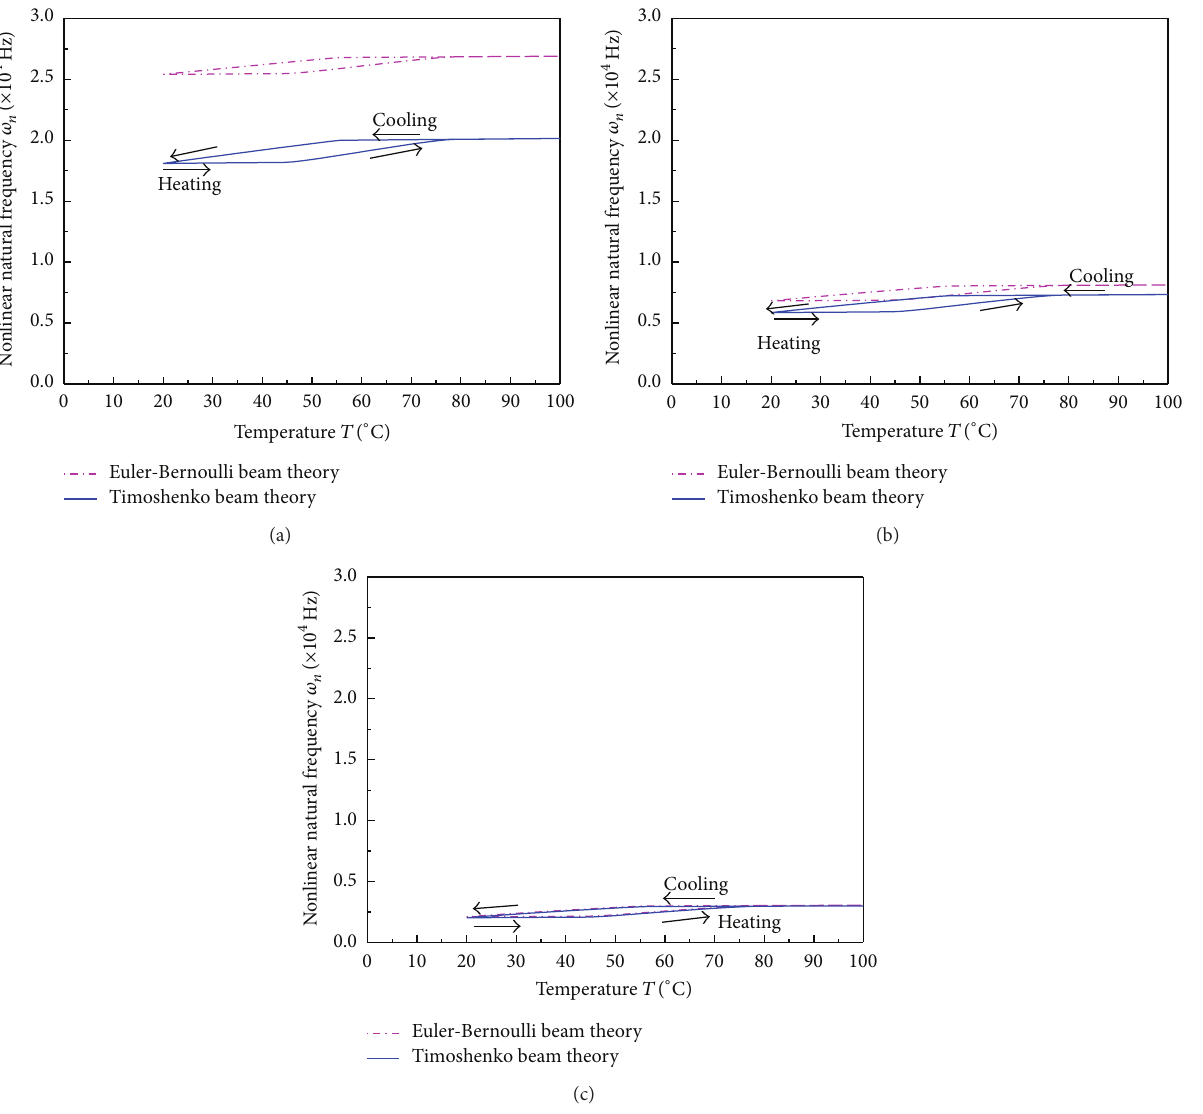
Figure 3: Variation of the nonlinear natural frequency with the actuation temperature of SMA fibers ( 𝜀 0 = 0.03 , 𝑉 𝑠 = 0.005 , and 𝐴 0 /ℎ = 1 ): (a) 𝐿/ℎ = 5 ; (b) 𝐿/ℎ = 10 ; and (c) 𝐿/ℎ = 20